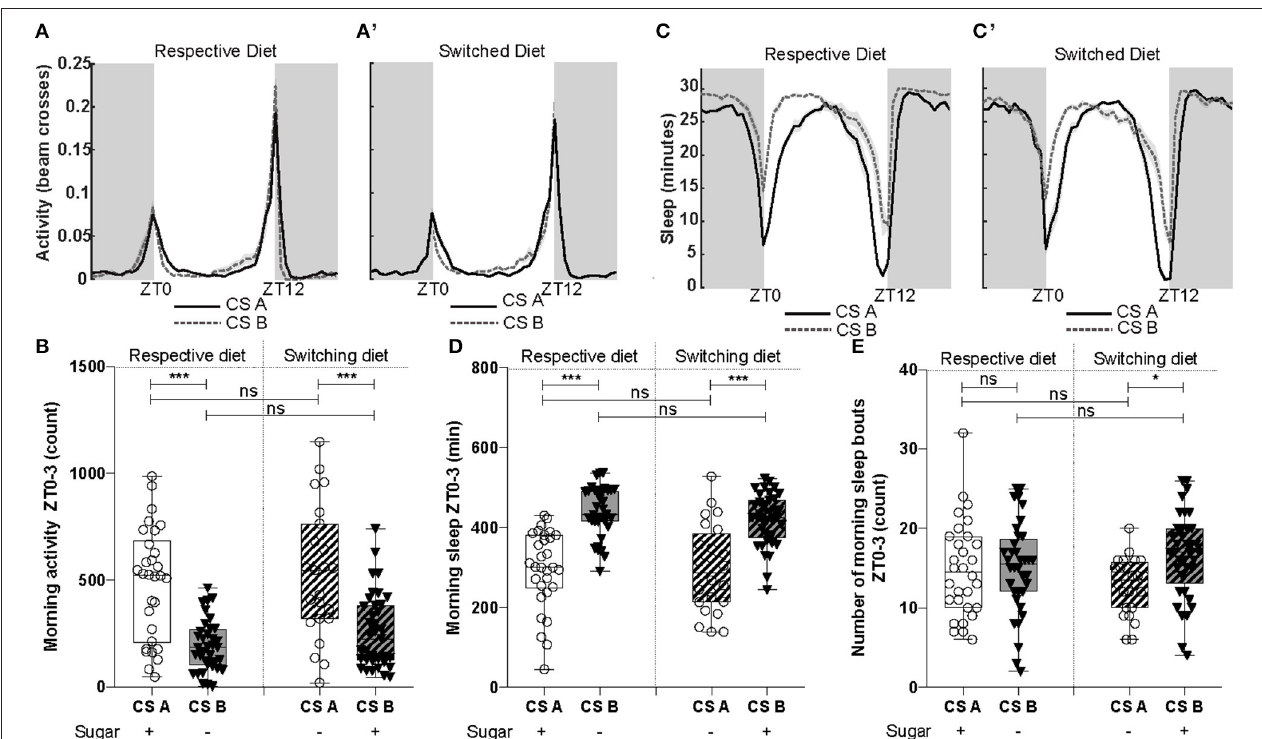
FIGURE 4 | Cs line presented differences in their activity and sleep patterns. (A) Representation of activity patterns across day (white) and night (gray) for both lines when raised on their respective or (A’) switching diet. (B) The CS A line was significantly more active during the morning (ZT0-3) when behavioral experiments were done [ F (1, 124) = 55.76, p = 1.34e-11]. Diet did not affect morning activity [ F (1, 123) = 0.29, p = 0.58]. (C) Sleep patterns of CS lines when raised on their respective and (C’) switching diets. (D) The line CS B slept significantly more during the first 3h of the morning [ F (1, 125) = 73,88, p = 3.16e-14]. Diet did not significantly affect morning sleep [ F (1, 124) = 0.42, p = 0.51]. (E) Number of morning sleep bouts (ZT0-3) were not significantly different between CS lines [ F (1, 125) = 3.72, p = 0.056] and diets [